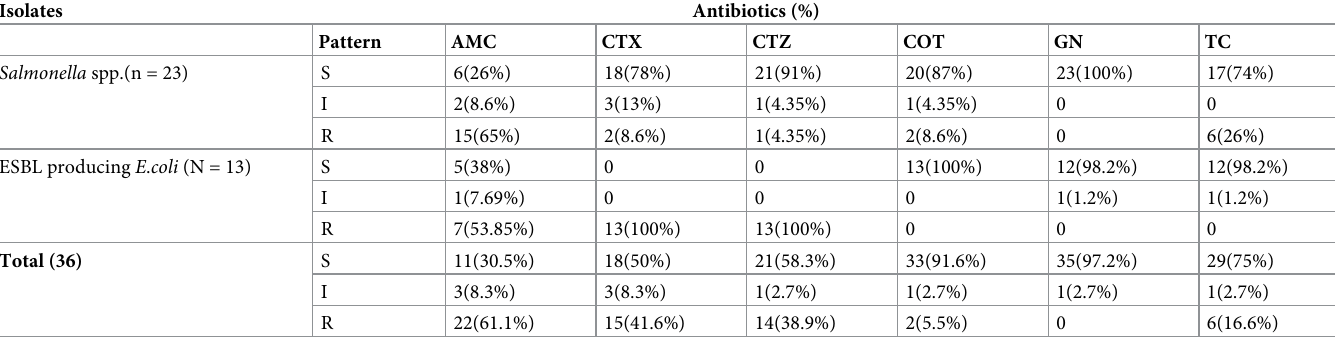
Table 4. Antibiotic susceptibility patterns of bacterial isolates from raw meat and swab samples collected from butcher shops at Hawassa city, Sidama regional state, Ethiopia, 2020 (n = 36). Isolates